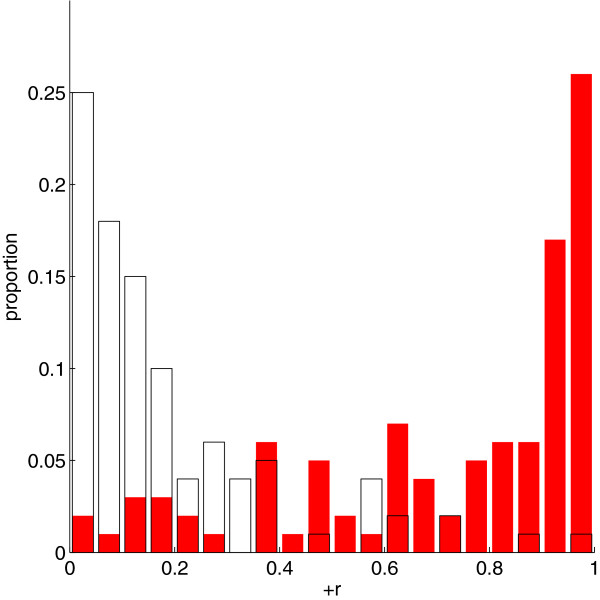
Distribution of maximum correlations between false positives and true nonzeros after the presumptive μP − valuephase transition for chromosome 22. Histogram of the maximum correlation (maximum of the positive roots of the r2 LD measure) between a false positive and true nonzero for chromosome 22, given s = 125, n = 5,000, and h2 = 0.5 (red). Also shown is one realization from the null distribution, generated by drawing an equal number of “false positives” at random from chromosome 22 (white).